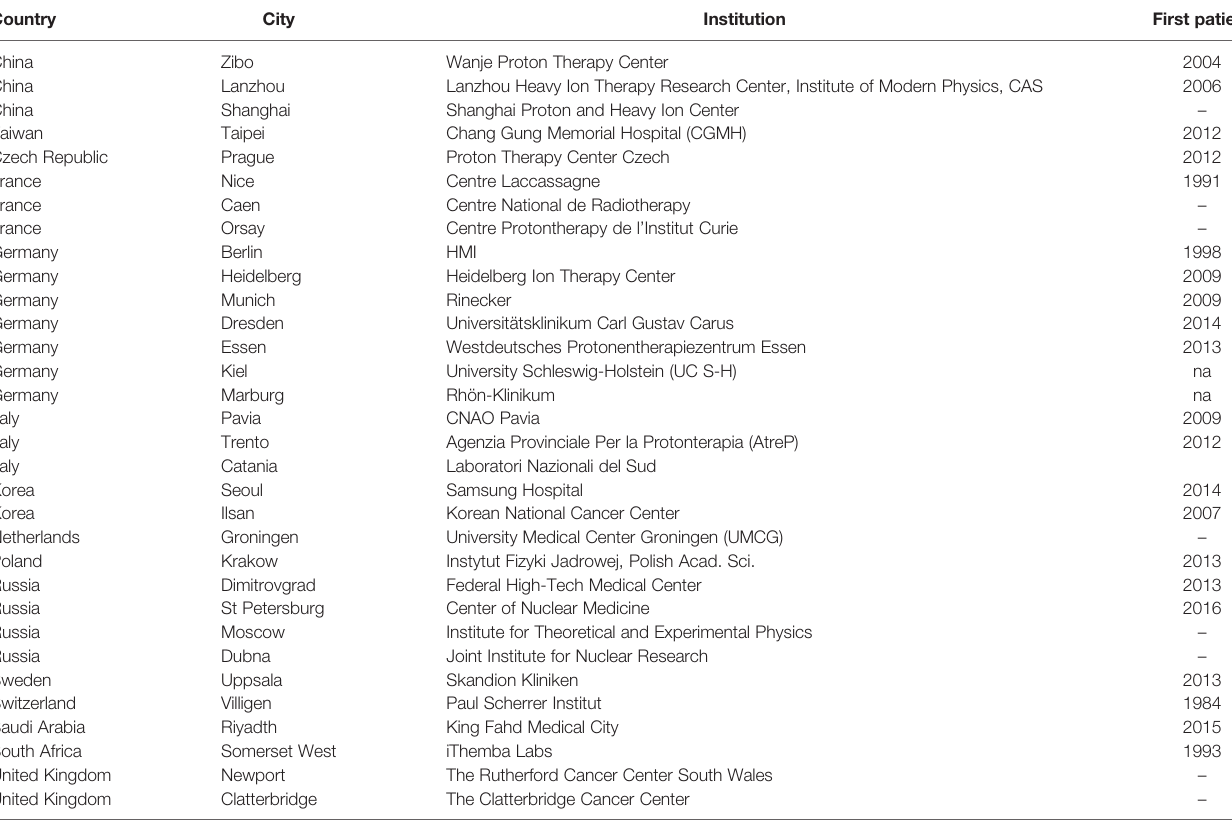
TABLE 1 | Partial listing of particle therapy centers in europe and elsewhere.